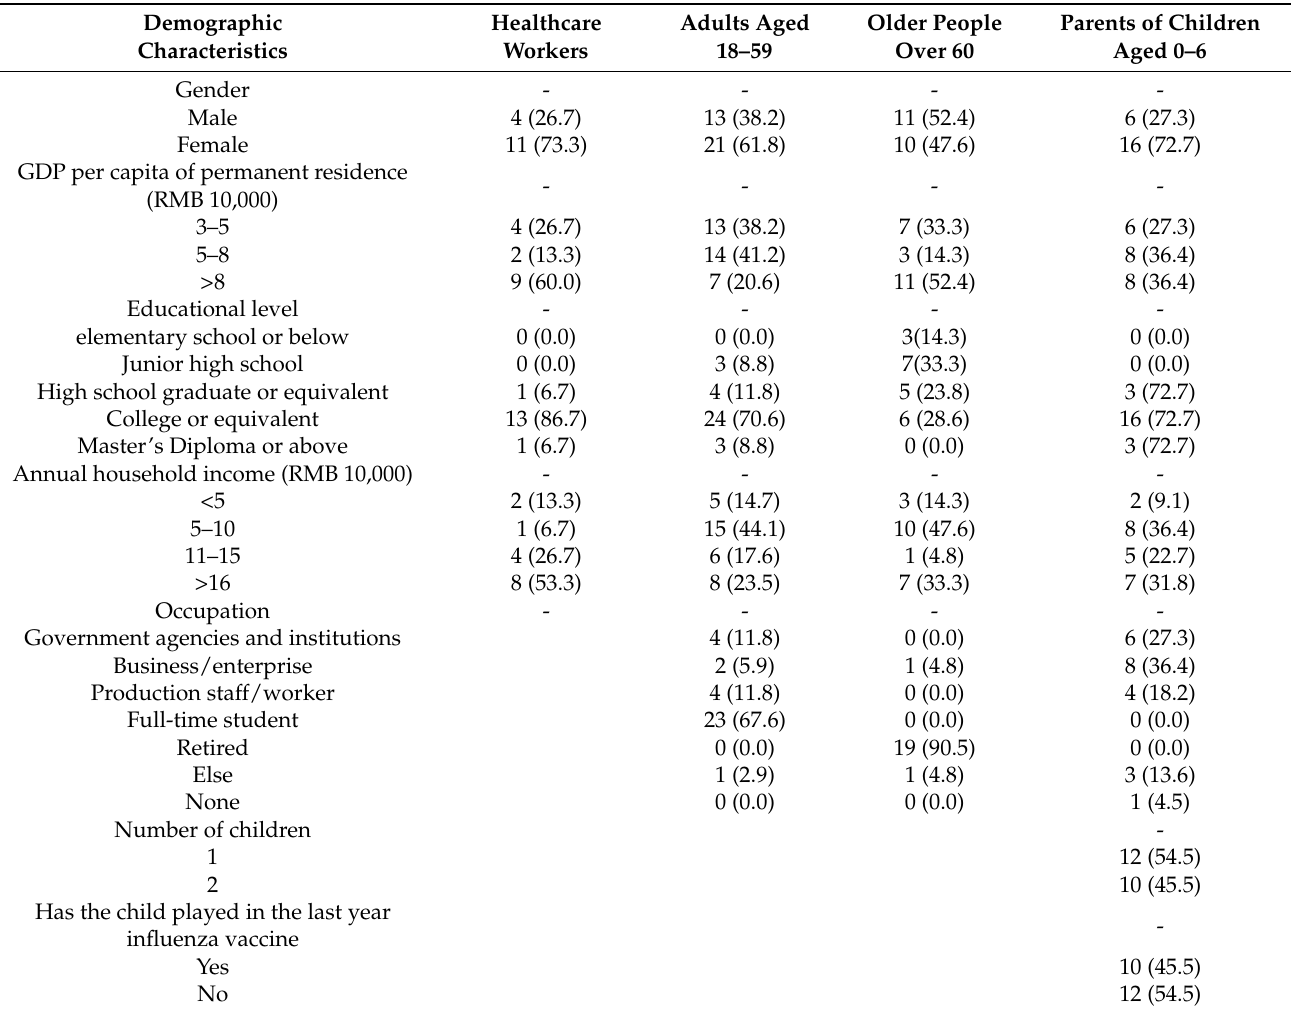
Table 2. Participants’ sociodemographic